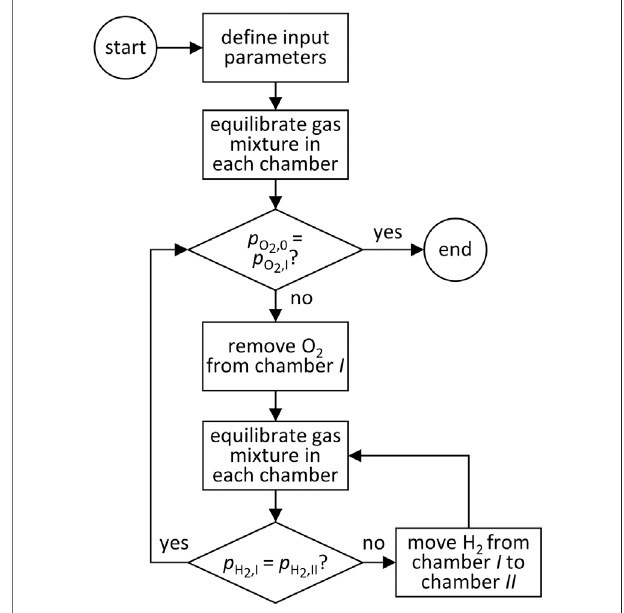
FIGURE 2 | A fl owsheet illustrating the logic applied in the dual- membrane reactor equilibrium